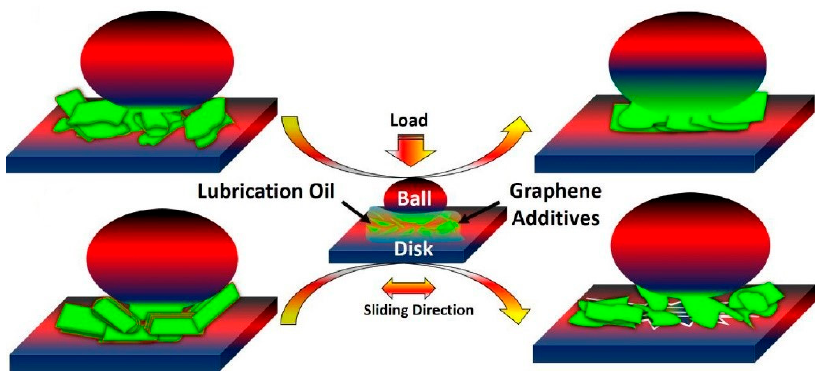
Figure 5. Schematic demonstration of the lubrication mechanism of the structural evolution of graphene additives. Reprinted with permission from [62]. © 2017 Elsevier B.V. All rights reserved.